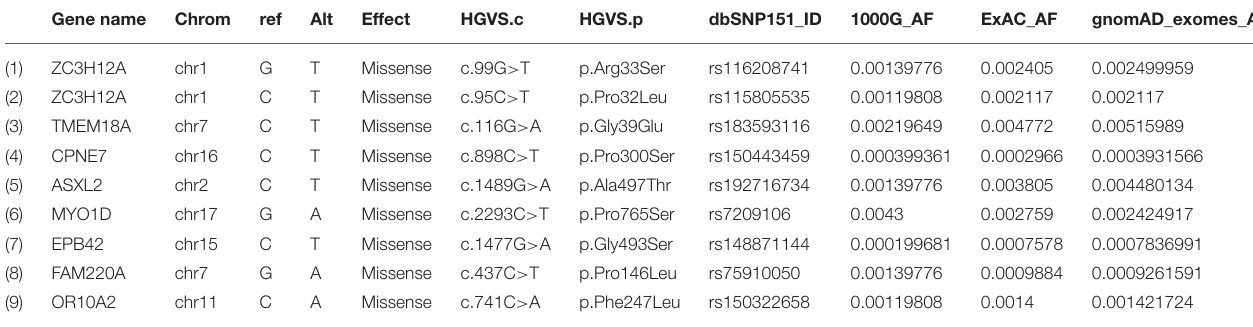
TABLE 1 | List of LD potential candidate variants that showed autosomal recessive inheritance pattern.